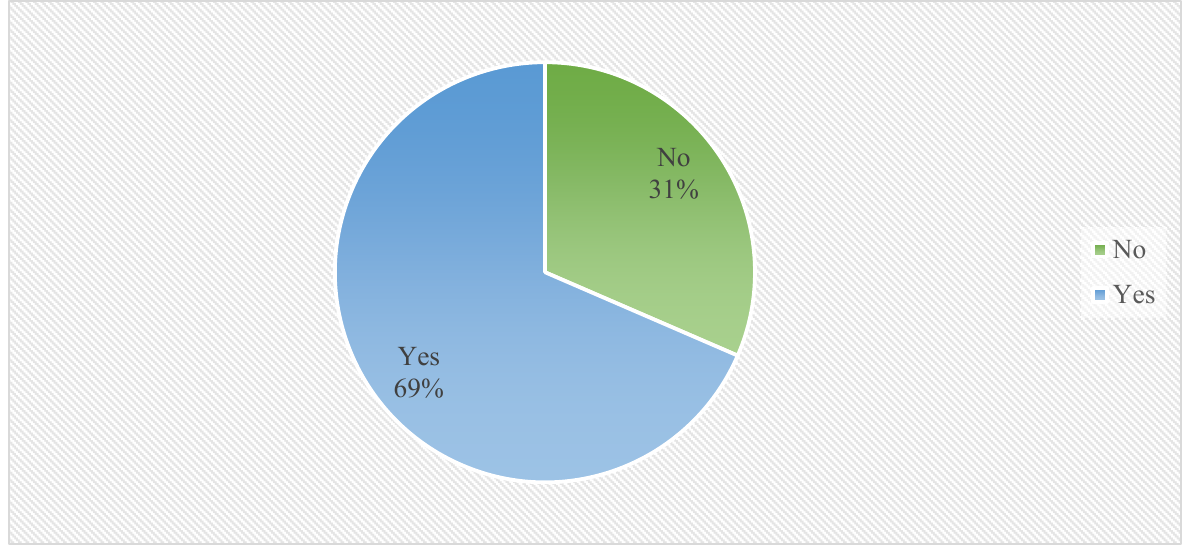
Figure 4. Implementation and completion of the projects. Source (Mamokhere and Meyer 2022).